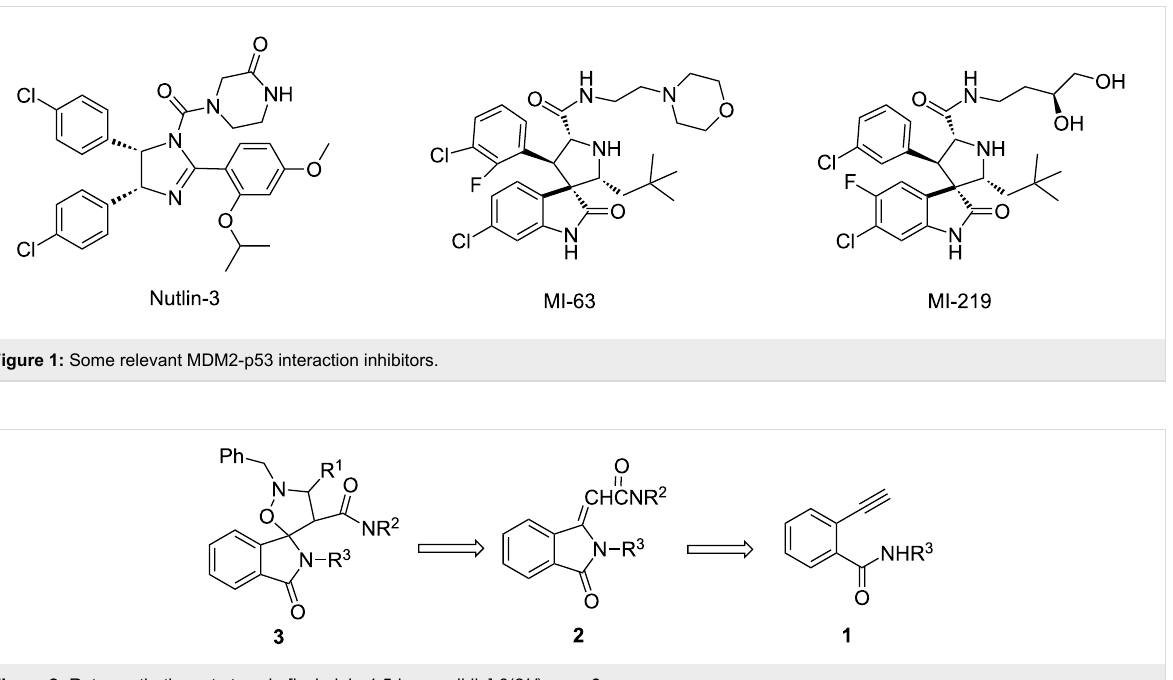
Figure 2: Retrosynthetic route to spiro[isoindole-1,5-isoxazolidin]-3(2 H )-ones 3